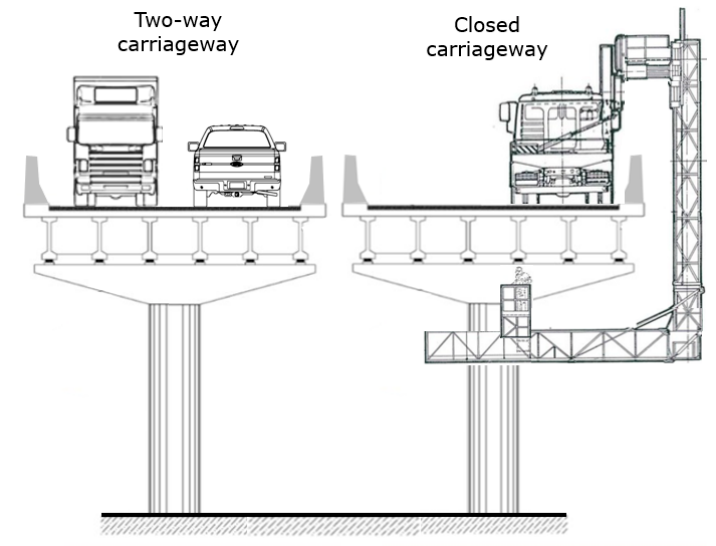
Figure 11. Dual bridge with a closed carriageway.